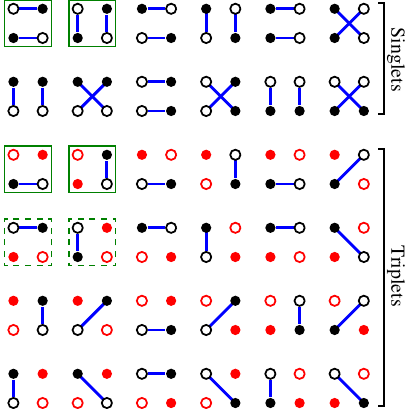
FIG. 28. Spinon wave-function components for singlet and triplets of two spinons and two antispinons, with the circles in 2 order 1 corresponding to the bright (spinon) regions in Fig. 26. 3 4 Spinons (on sublattice A ) and antispinons (on sublattice B ) are denoted by solid and open circles, respectively, and singlet pairs are indicated by lines connecting circles. Unpaired red circles correspond to up spins (or other triplet states of the pairs). The components enclosed by solid green squares represent the dominant components of the wave functions as discussed in connection with Fig. 27, and the dashed green boxes indicate further regular components in the triplet sector. All other configurations correspond to cross terms existing when spinons and antispinons can trade